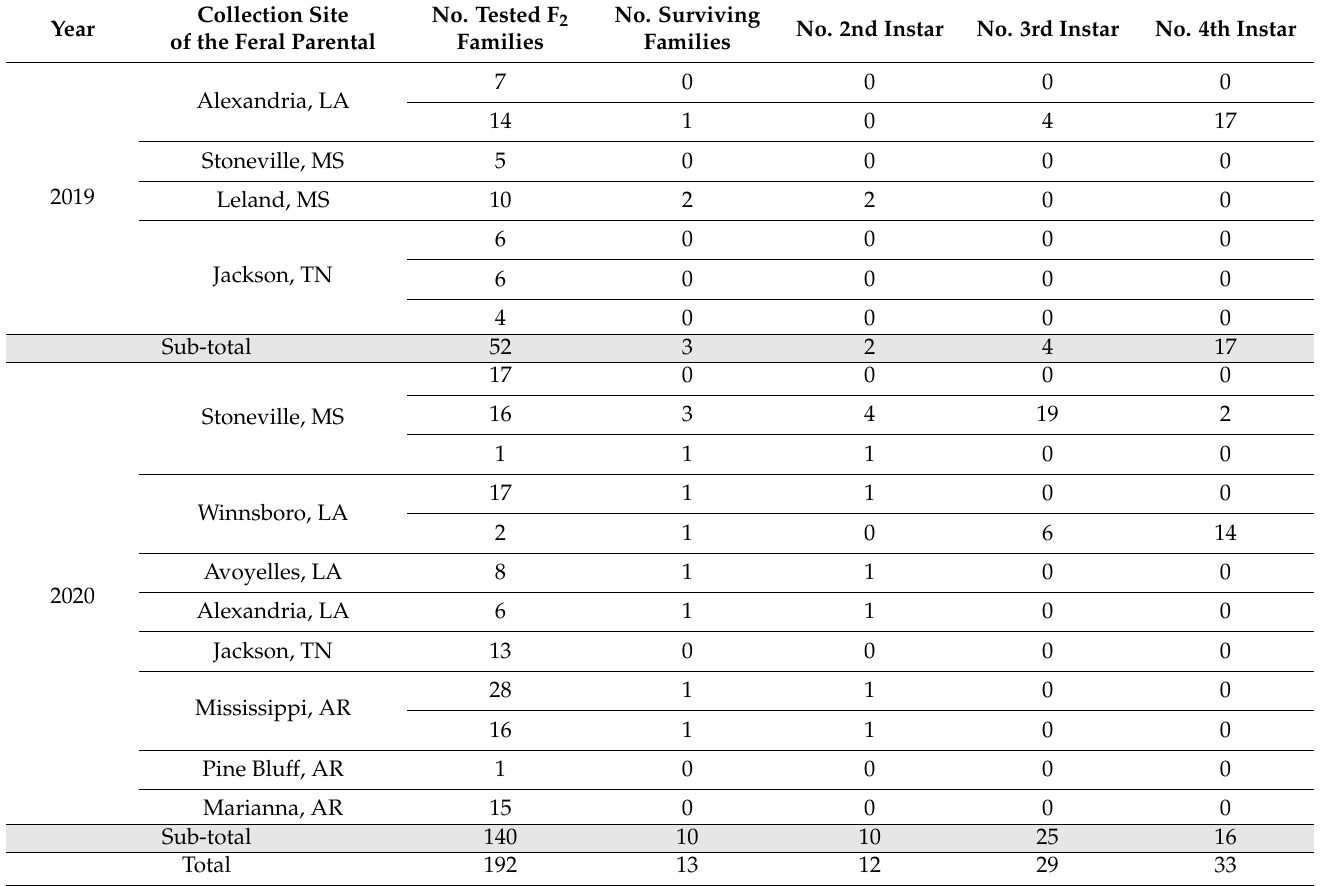
Table 2. Survival of F 2 families of Helicoverpa zea on the discriminating concentration of 3.0 µ g/cm 2 Vip3Aa39 after 7